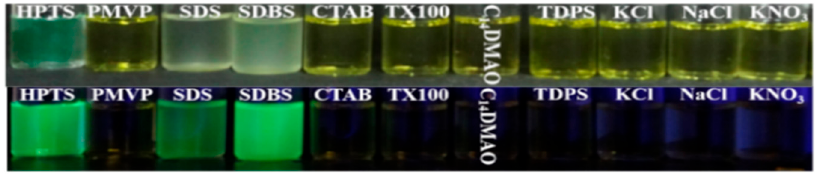
Figure 4. Changes in the color of HPTS/PMVP 41 - b -PEO 205 complex in water in the presence of various analytes. [HPTS] = 0.05 mM; [PMVP-PEO] = 0.4 mM; [SDS] = [SDBS] = [CTAB] = [Triton X-100]